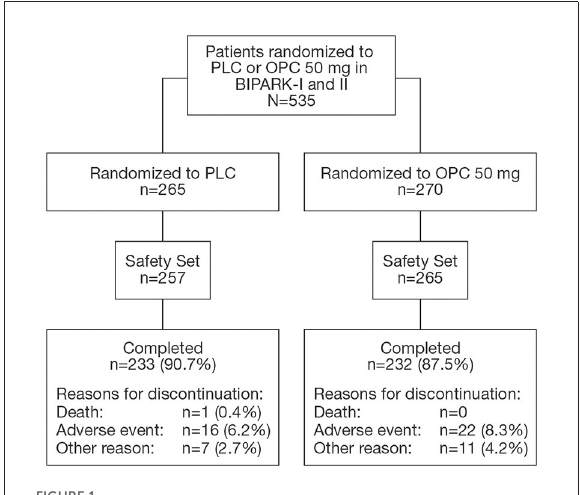
FIGURE1 Flowchart of patient disposition. OPC, opicapone; PLC,